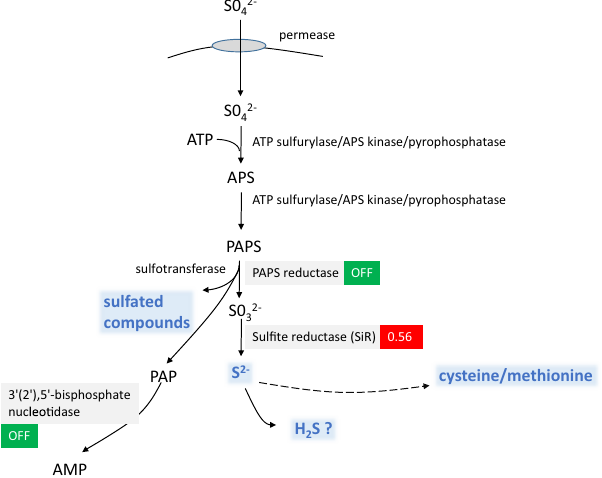
Figure 7. Theoretical schematic view of sulfur reduction in Phytophthora and effects of DMTS (red) and MMTS (green). The scheme was designed based on the presence in the proteome of P. infestans T30-4 of homologues of actors found classically in plants and fungi (adapted from 47 ). Sulfate ions are transported by permeases across the plasma membrane and transferred in the cytoplasm to adenosine (ATP) by a tripartite enzyme comprising an ATP sulfurylase domain, a kinase domain (adenosine 5 ′ -phosphosulfate kinase, APS kinase) and a pyrophosphatase domain 27 . The product of this reaction, the phospho-adenosine phosphosulfate (PAPS), is then converted to sulfite by the PAPS reductase, then into sulfide by the sulfite reductase (SiR). Sulfide can oxidize into hydrogen sulfide (H 2 S) or integrate the metabolism of cysteine and methionine. In plants, sulfation occurs on secondary metabolites or hormones, like glucosinolates and phytosulfokines and is controlled by the PAPS reductase and a sulfotransferase 48 . During this process, a harmful compound, called 5 ′ -phosphoadenosine 3 ′ -phosphate (PAP), accumulates. PAP is detoxified in plants by a 3 ′ (2 ′ ),5 ′ -bisphosphate nucleotidase. This enzyme was detected in the proteome of P. infestans . The mechanisms of sulfation in Phytophthora are unknown. Modifications in protein amounts observed upon sVOC treatments are shown in red (DMTS) and green